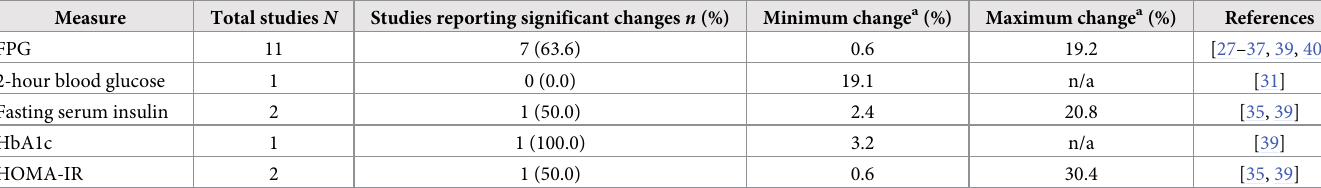
Table 3. Changes in glycemic